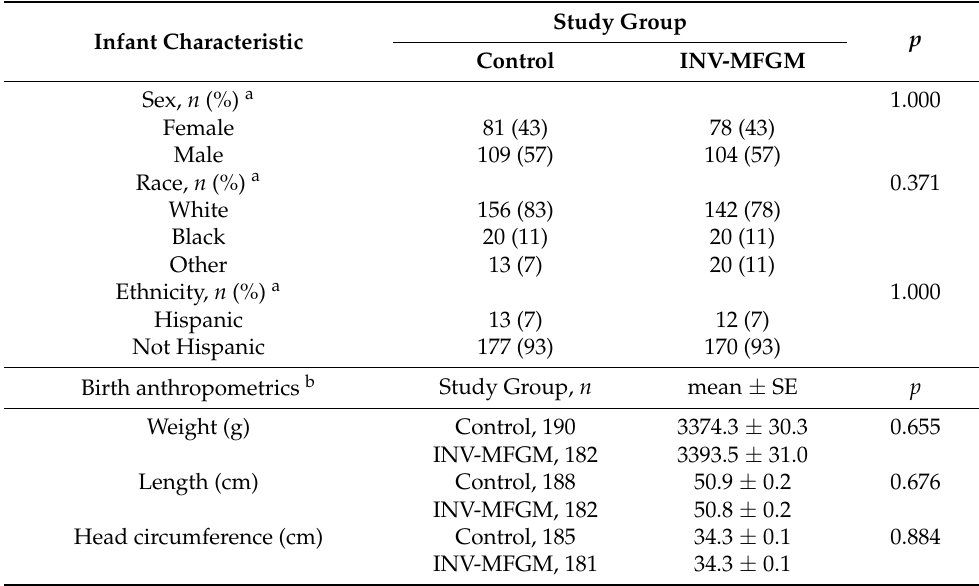
Figure 1. Flow of study participants. Table 2. Infant characteristics at birth and study